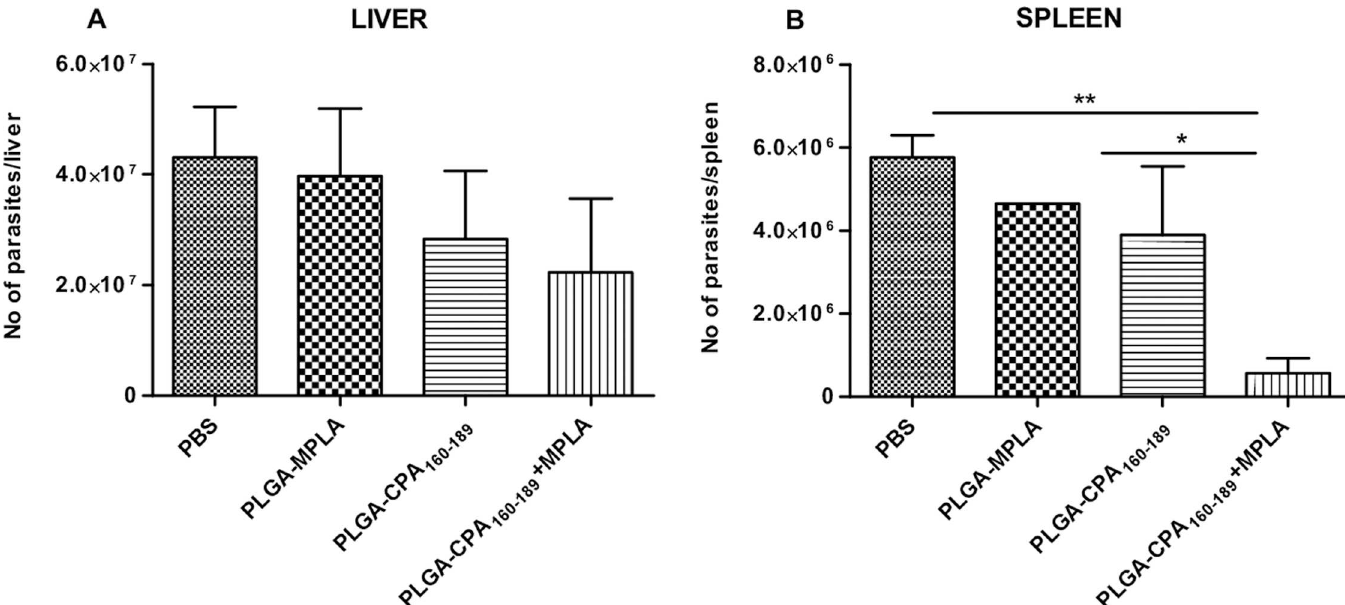
Fig 8. Evaluation of vaccine-mediated protection against L . infantum infection in BALB/c mice 1 month post intravenous challenge. Determination of parasiteload in (A) the liver and (B) the spleenby limiting dilutionassay in vaccinatedand non-vaccinated mice 1 month post challenge with L . infantum . Results are presented as means ± SD of five individualmice per group, representative of two independentexperiments with similar results. * p < 0.05, ** p < 0.01, *** p < 0.001were assessed by one-way ANOVA and Tukey’s